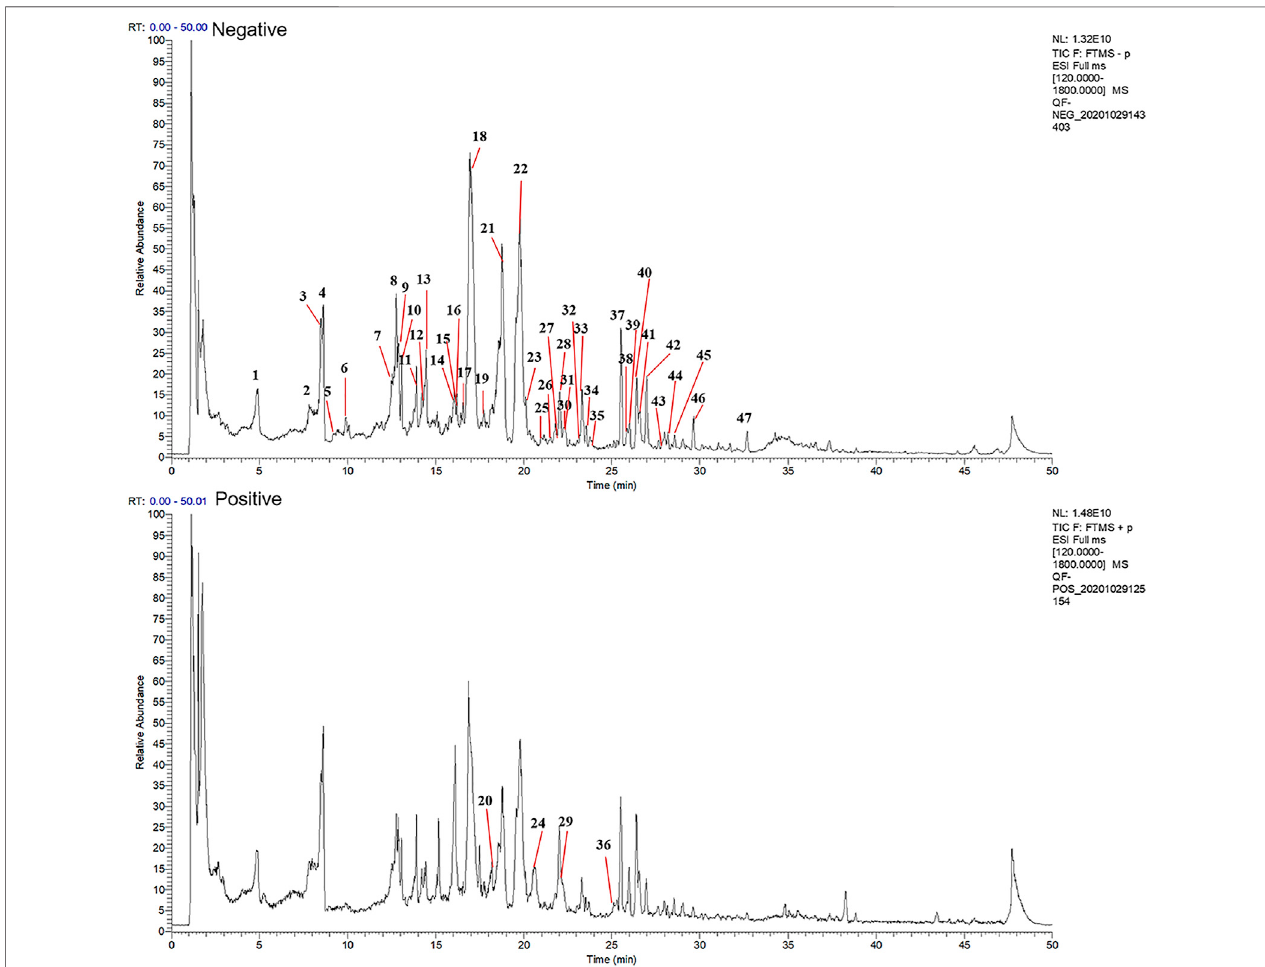
FIGURE 2 | Total ion chromatogram monitored in negative and positive ion modes for QFLT extract.